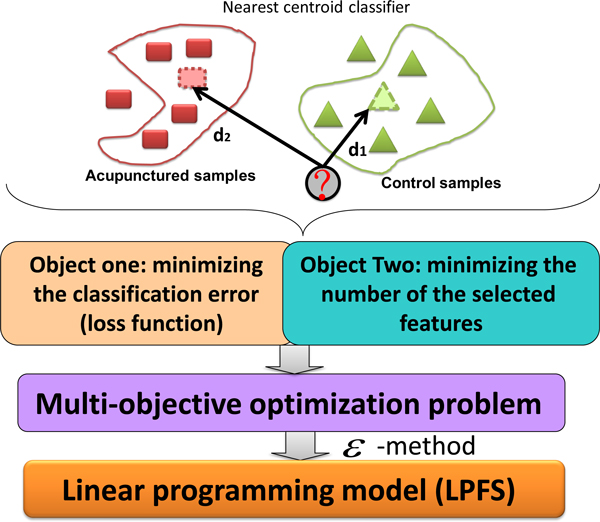
The schematic illustration of LPFS. Under the nearest centroid framework, LPFS requires to minimize the classification error and the number of selected features, which leads to a multi-objective programming. To ensure the computational efficiency, a linear programming is solved to identify biomarkers.